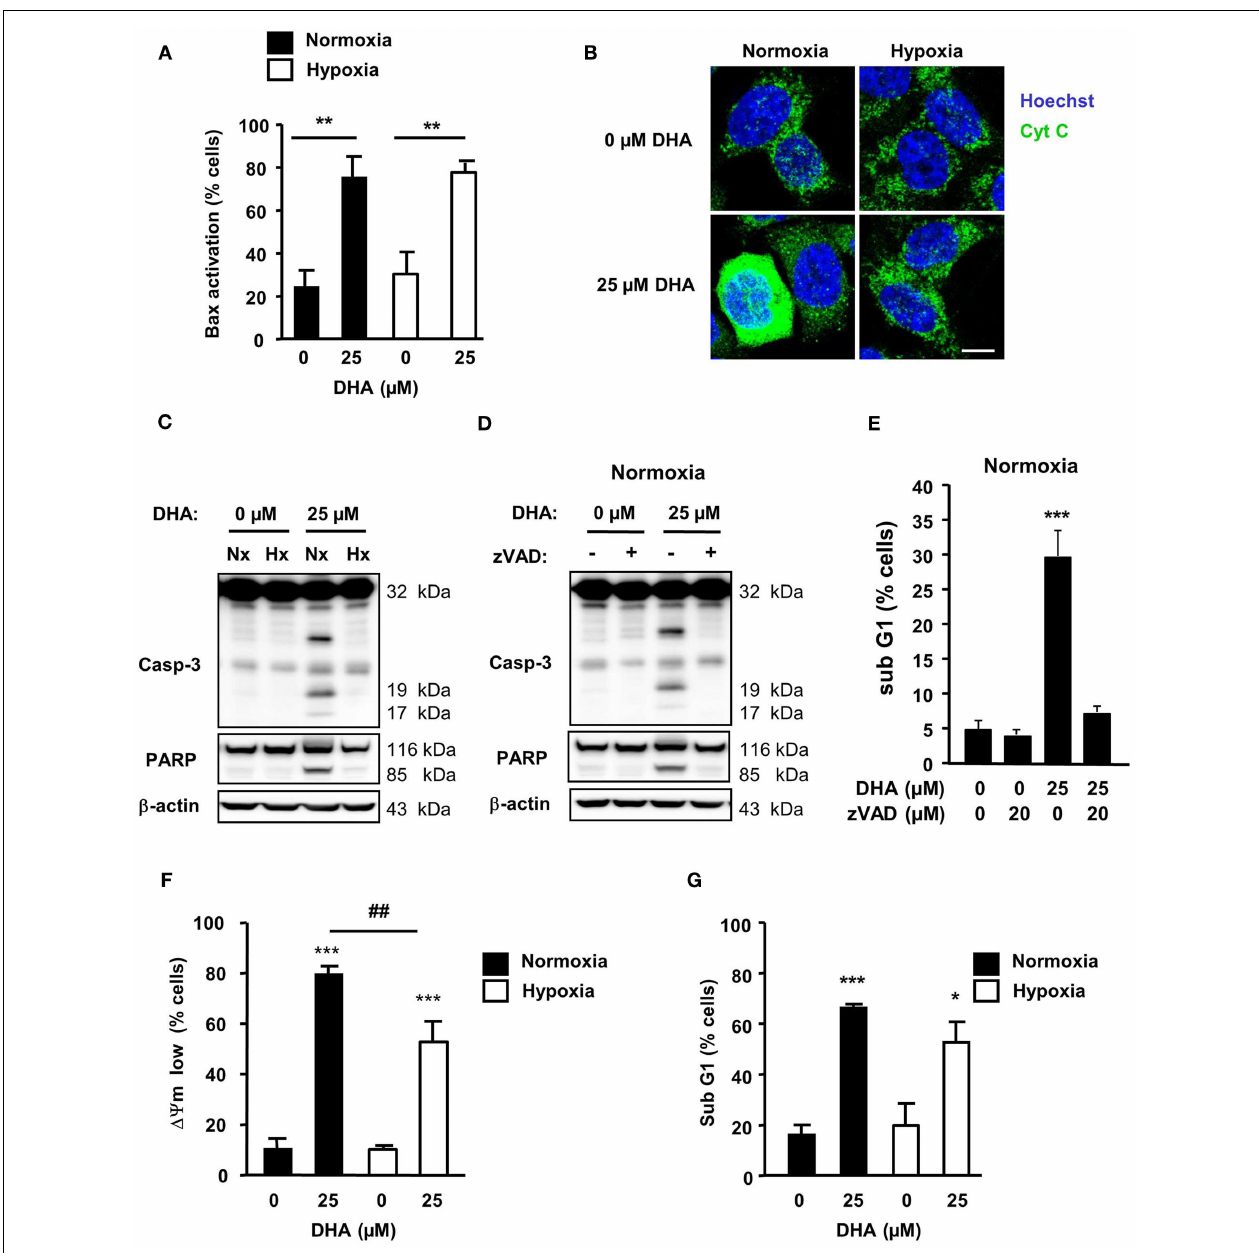
are representative blots out of three independent experiments. (C) DHA-induced caspase-activation is abrogated in hypoxia. Caspase-3 activation (D) and DNA-fragmentation (E) can be blocked by co-treatment with the pan-caspase inhibitor zVAD-fmk under normoxic conditions. DHA induces depolarization of the mitochondrial membrane potential [ ∆Ψ m, (F) ] and DNA-fragmentation [sub-G1, (G) ] in normoxia and hypoxia. Depolarization of ∆Ψ m (F) and DNA-fragmentation (G) were determined at 24h after treatment by flow cytometry. (A,E–G) Data represent means ± SD from at least three independent experiments. P -values were calculated applying unpaired two-tailed t -test; * P < 0.05; ** ,## P < 0.01; *** P < 0.001. *Indicates the significance between the solvent-treated control cells and DHA-treated cells either in normoxia or hypoxia, # indicates the significance between normoxic and hypoxic cells treated with the same concentration of